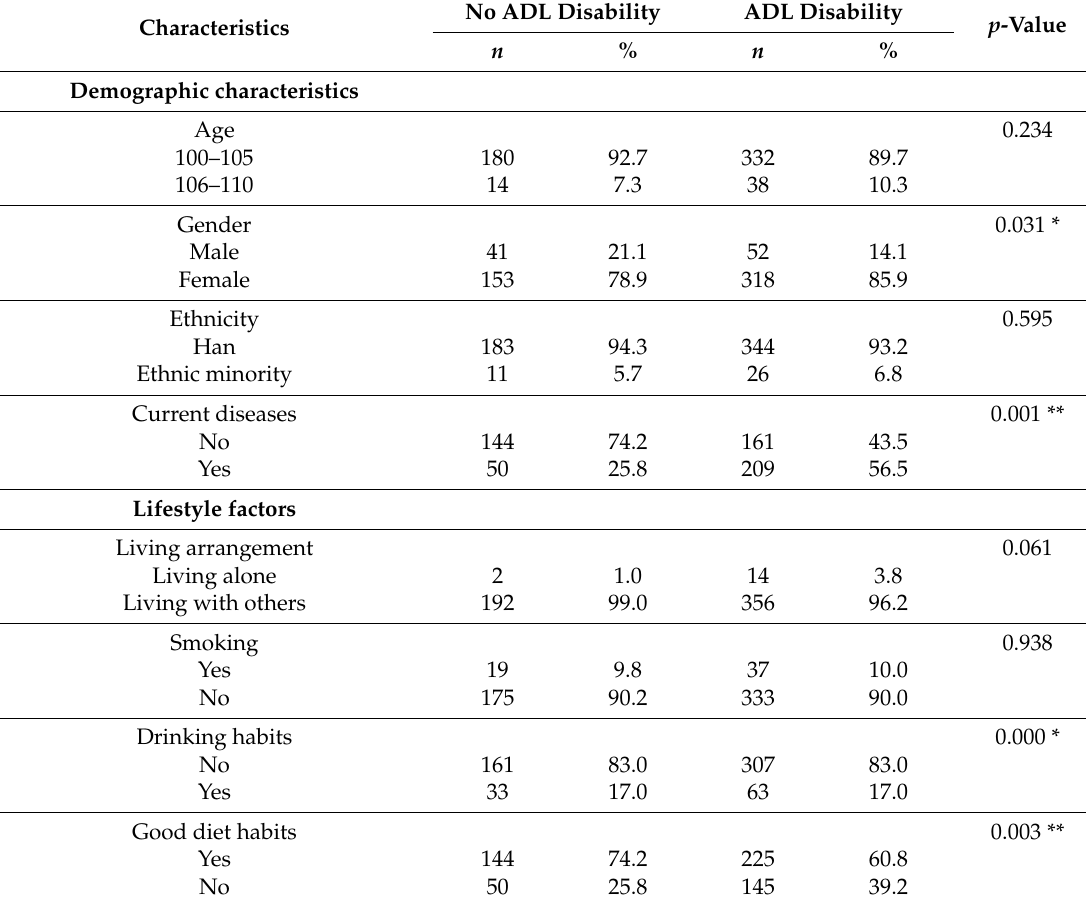
No ADL Disability ADL Disability